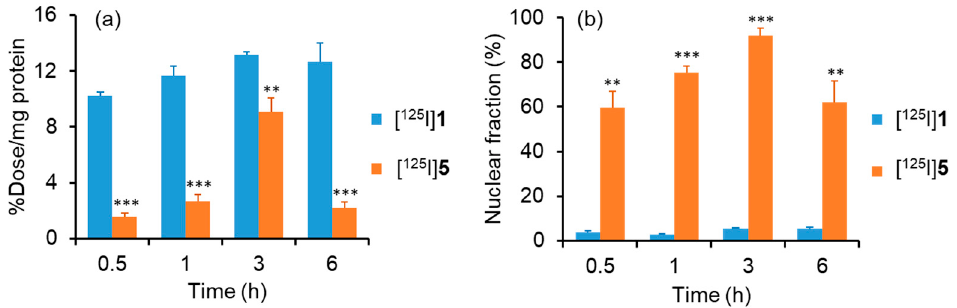
Figure 3. Cell uptake study using [ 125 I] 1 and [ 125 I] 5 . ( a ) The cellular uptake and ( b ) nuclear uptake